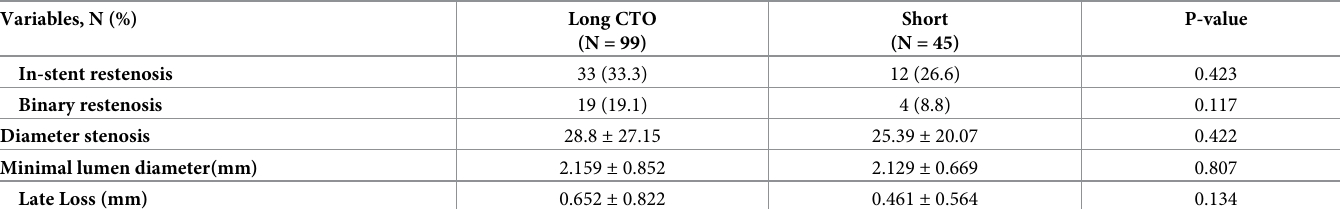
Table 5. Six-month angiographic